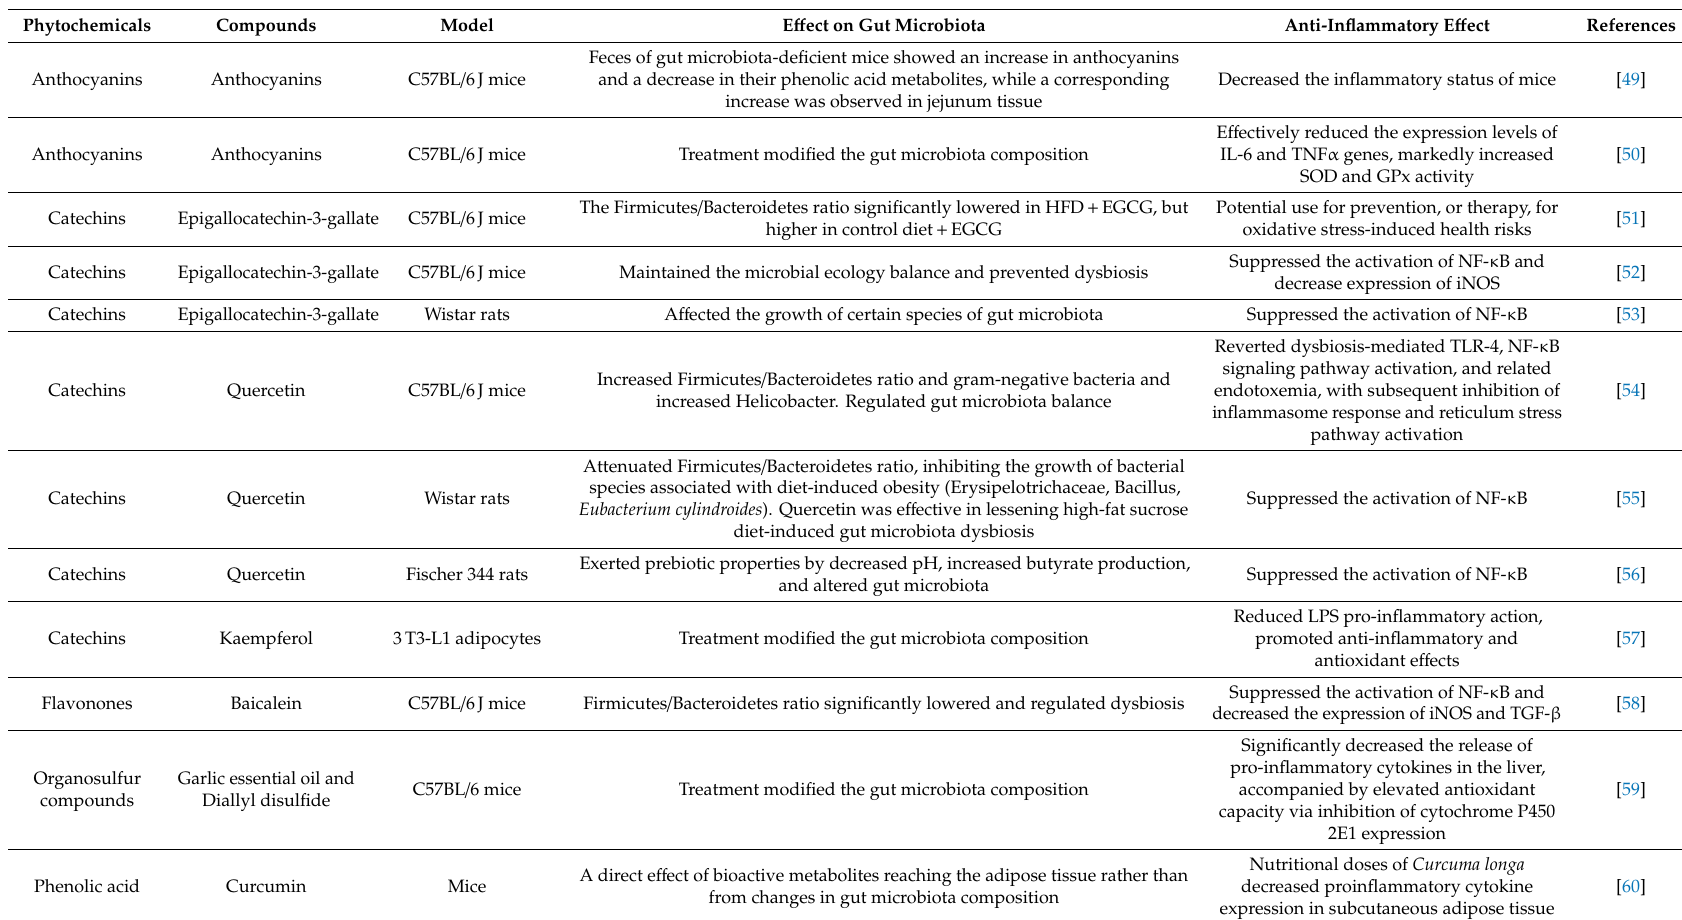
Table 1. E ff ects of phytochemicals on gut microbiota and their anti-inflammatory e ff